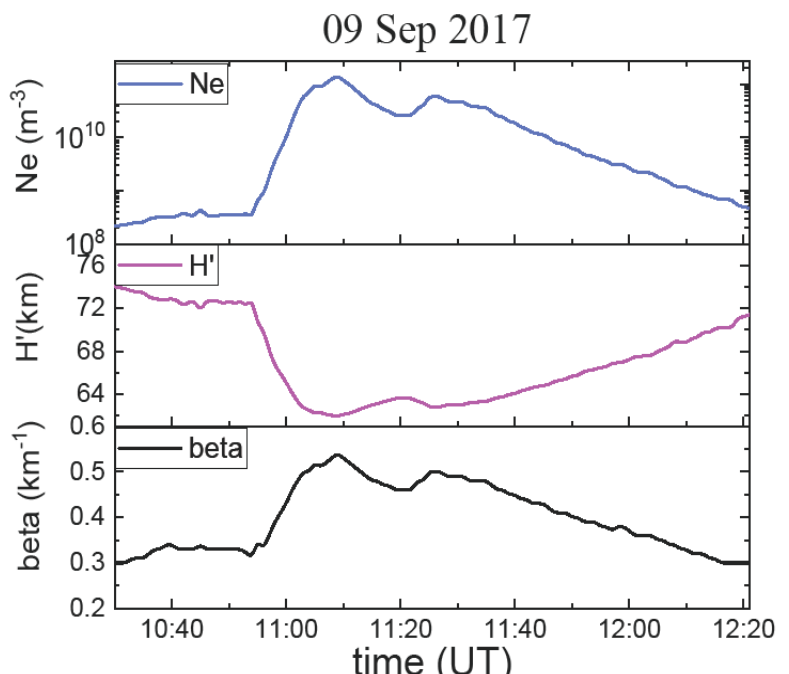
Figure 6. The sharpness β , effective reflection height H ’, and electron density at reference height h = 74 km during occurrences of M3.7 ‐ class solar flare on 9 September 2017 from lower to upper panel, respectively.